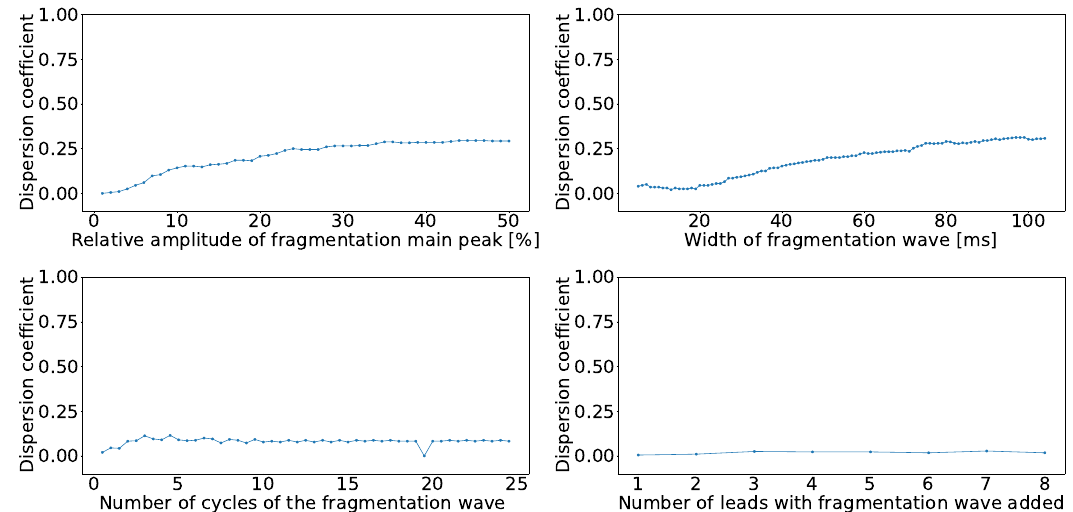
Figure 5. Dispersion coefficient against the fragmented wave amplitude ( upper left ), fragmented wave width ( upper right ), fragmented wave number of cycles ( lower left ), and number of affect lead ( lower right ) for independent-lead PCA model.